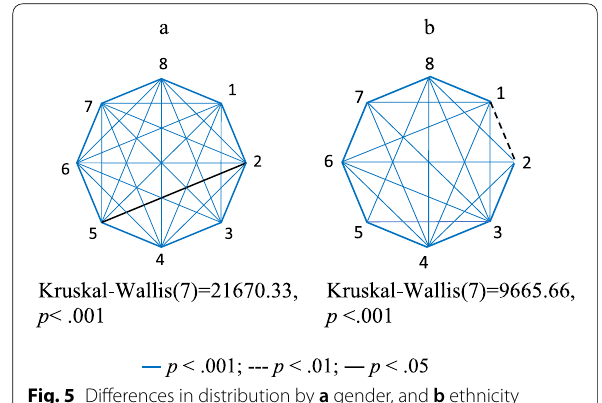
Fig. 5 Differences in distribution by a gender, and b